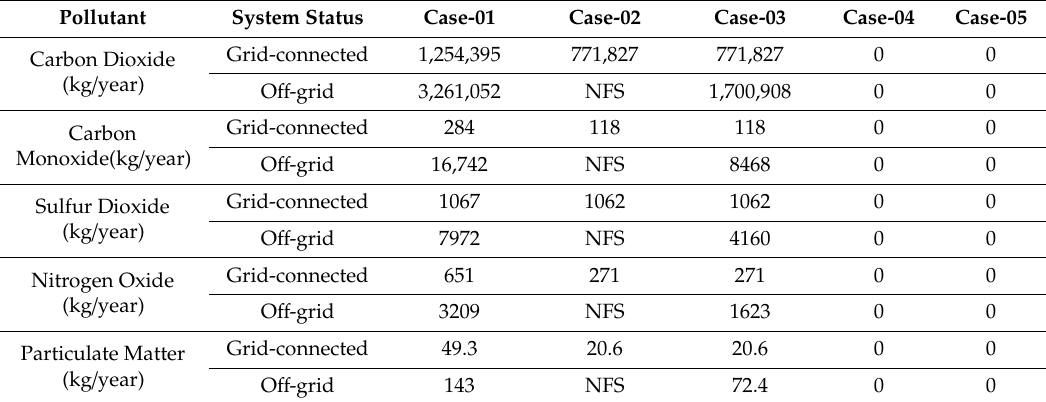
Table 18. Case-wise comparison of GHG